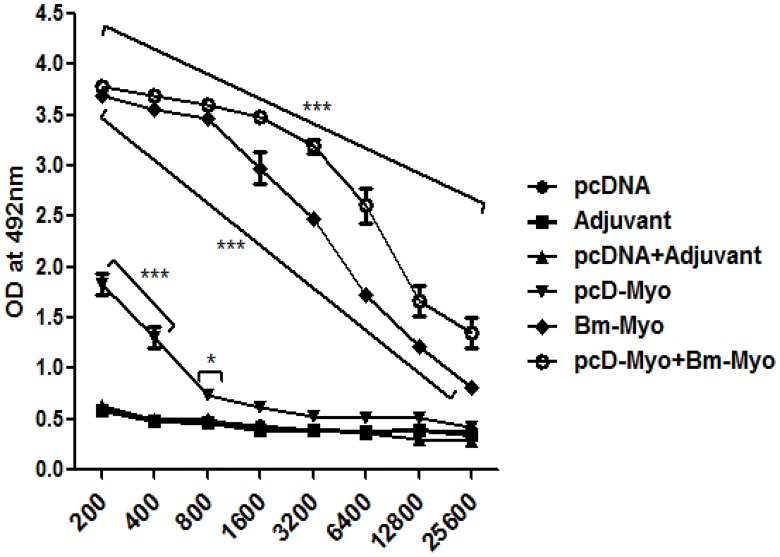
IgG titers were determined by indirect ELISA from serum obtained after last immunization booster.The IgG levels was significantly heightened (*** P<0.001) in pcD-Myo+Bm-Myo and Bm-Myo vaccinated mice at all dilutions over their respective controls (pcDNA+Adjuvant; Adjuvant) while pcD-Myo showed significantly increased IgG at lower dilutions (* P<0.05 to *** P<0.001) over pcDNA control group, shown in figure, howeve,r the difference was significant as compared to pcD-Myo+Bm-Myo and Bm-Myo (*** P<0.001 at dilution 1:1600 to 1:25600); pcD-Myo+Bm-Myo and pcD-Myo (*** P<0.001 at all dilution); Bm-Myo and pcD-Myo (*** P<0.001 at all dilution) (not shown in figure).